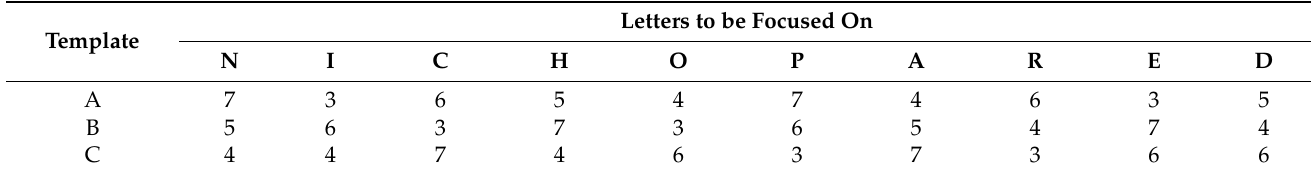
Table 2. Number of presentations for each letter according to the template